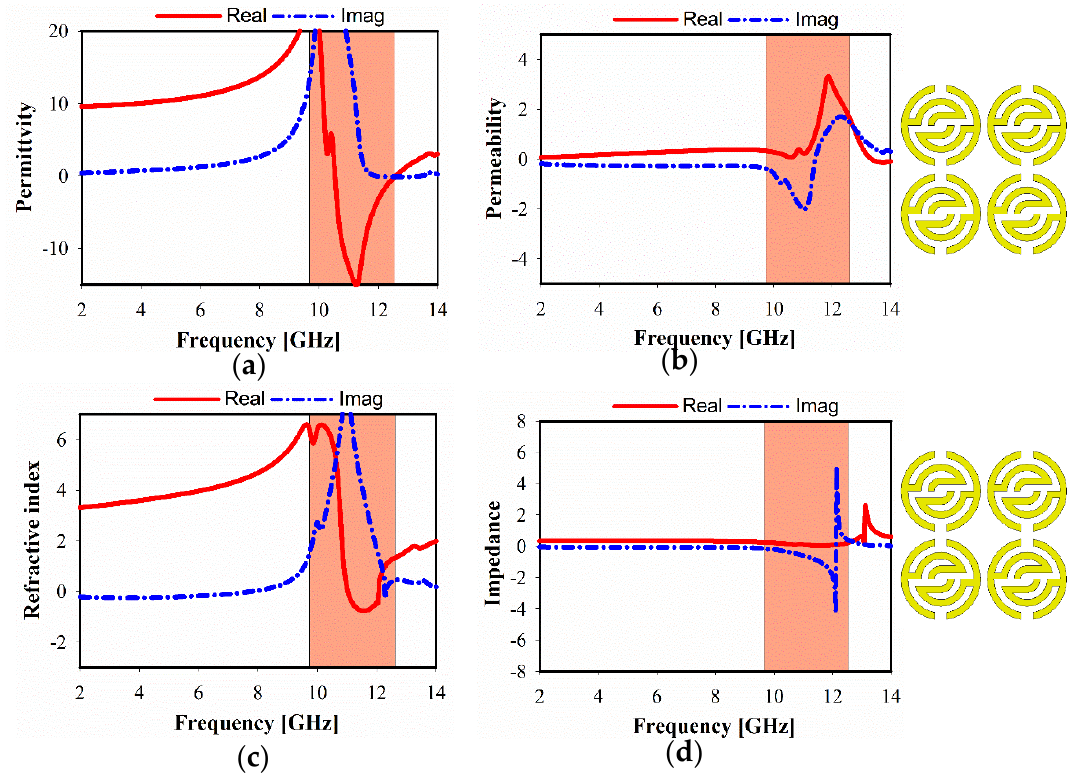
Figure7. Metamaterial, simulatedresultsof2 × 1unitcell: ( a )permittivity, ( b )permeability, ( c )refractive Figure 7. Metamaterial, simulated results of 2 × 1 unit cell: ( a ) permittivity, ( b ) permeability, ( c ) index, and ( d ) impedance. Sensors 2020 , 20 , 796 9 of 16 refractive index, and ( d ) impedance.